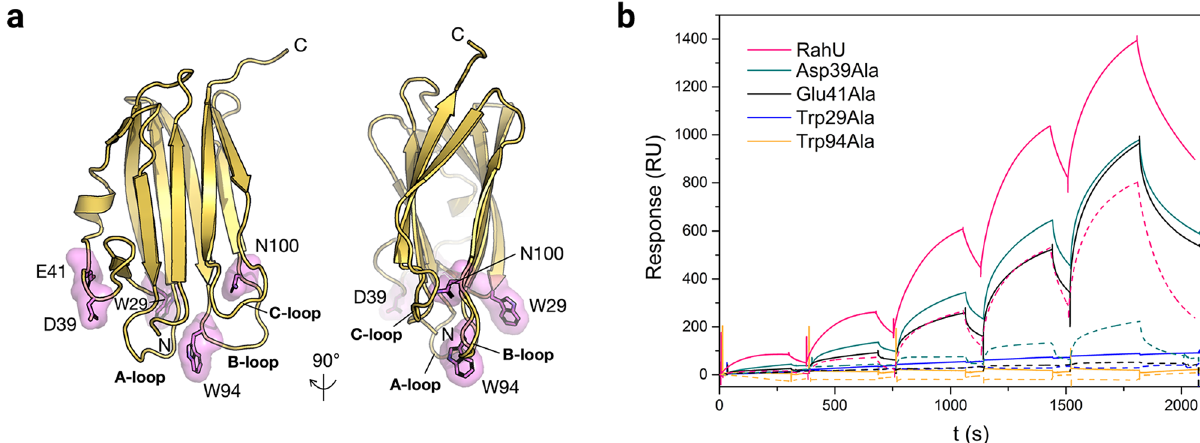
Figure 4. Interaction of RahU single alanine substitution derivatives with the CPE-enriched lipid vesicles. ( a ) RahU structure with marked residues substituted by alanine. ( b ) Binding of single alanine substitution RahU derivatives (4 µM) to the equimolar or CPE/POPC/cholesterol vesicles, either in 10 mM Hepes (solid line) or in 20 mM Tris buffer (dotted line). The vesicles were immobilized to Biacore L1 chip to 7000–11,000 RU and the analytes at 4 µM were injected for 300 s at 10 μL/min flow rate. To show only the RahU-vesicle interaction, the baseline was set as 0 RU after vesicle immobilization. Representative sensorgram from two independent experiments are